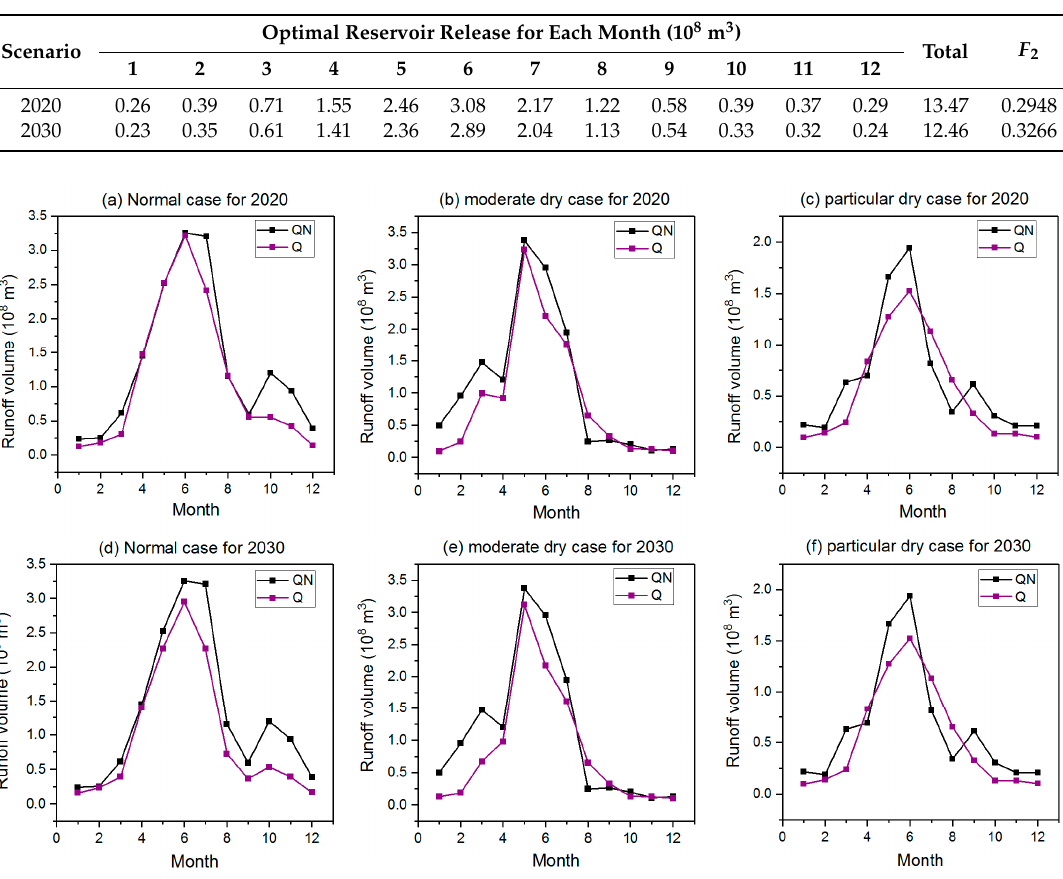
Table 3. The actual average release ( Q ) of downstream Xihe reservoir in different scenarios.